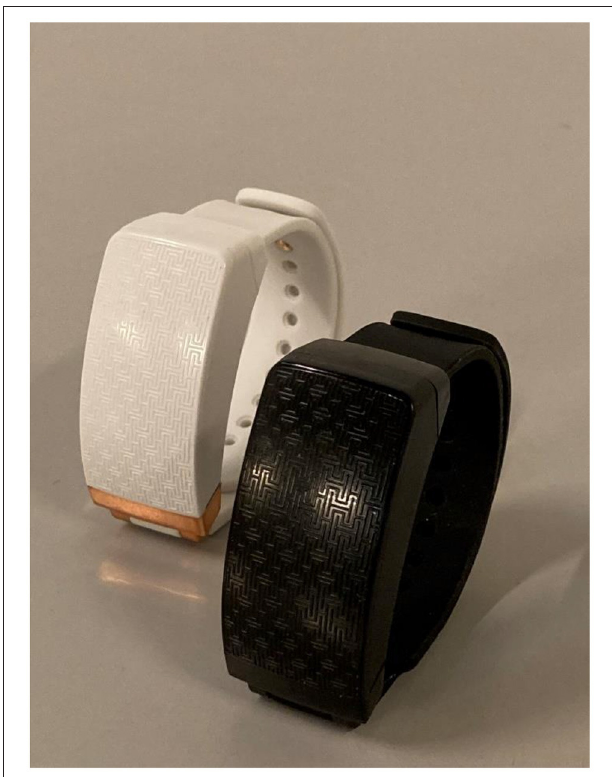
FIGURE 1 | A pair of Hey